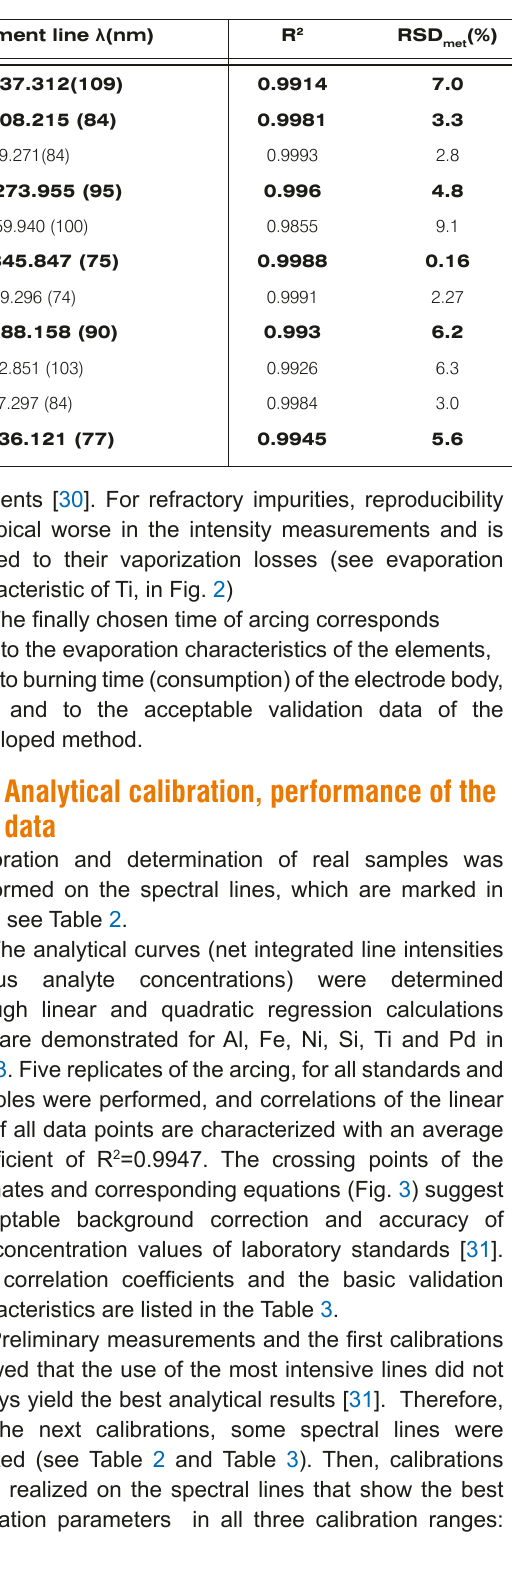
Table 3. The basic metrological and validation characteristics of the developed method; LOD, LOQ - expressed in weight percent (%). Element line λ